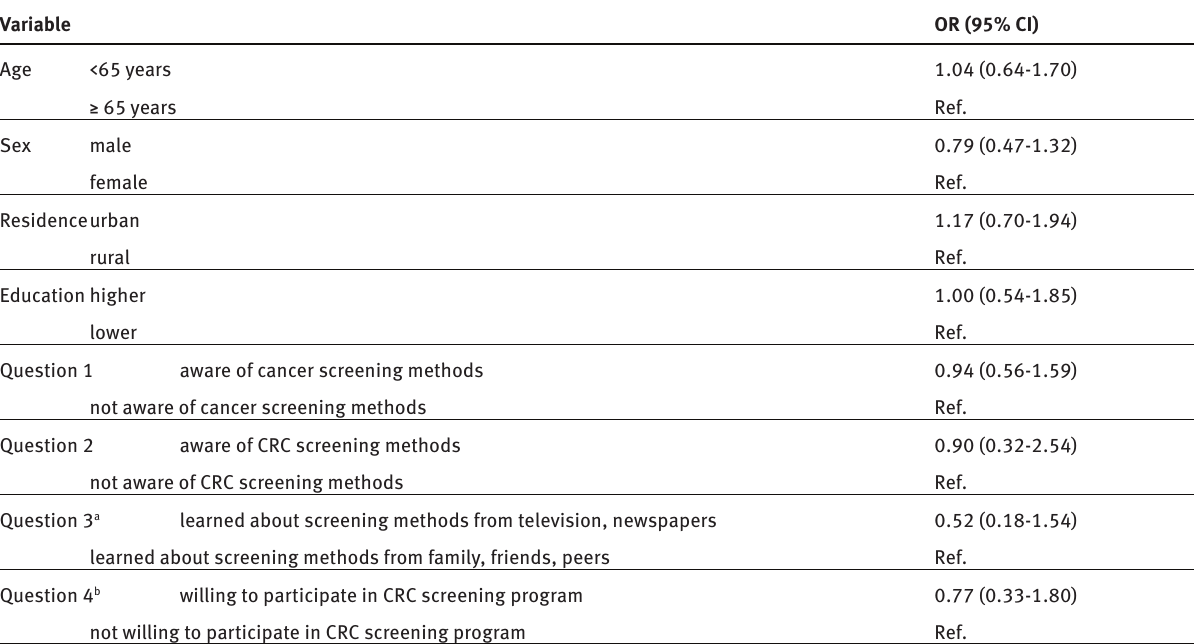
Table 2: Socio-demographic and awareness related factors tested as predictors of colorectal cancer stage at diagnosis